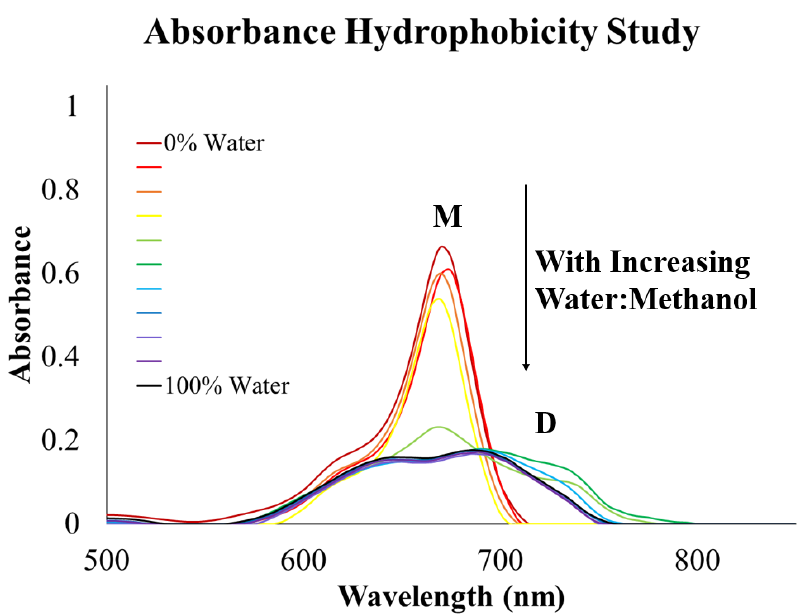
Figure 4. Absorbance spectra of compound 5 (3 µM) in increasing percentages of water (0, 10, 20, 30, 40, 50, 60, 70, 80, 90, and 100%) show a high degree of dimerization and formation of J-aggregates.